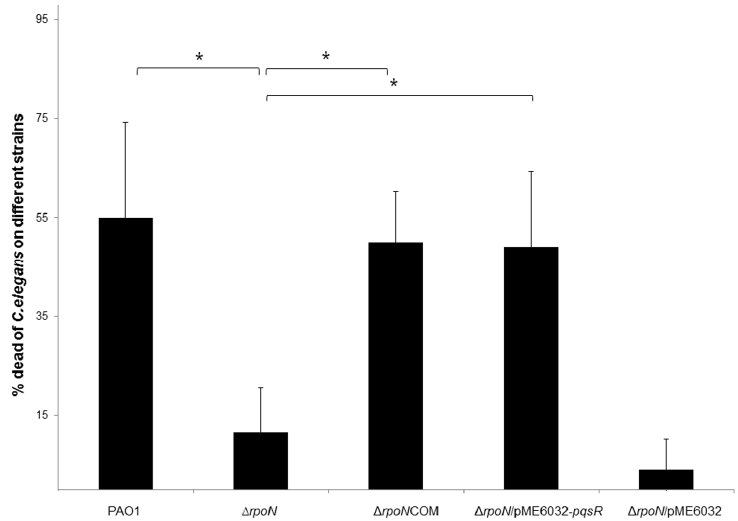
Figure 4. Death rates of Caenorhabditis elegans ( C. elegans ) growing on the lawn of different P. aeruginosa strains on agar plates. Means and S.D. from six replicates are shown. One-way ANOVA was performed for testing differences between groups. * p ≤ 0.05.